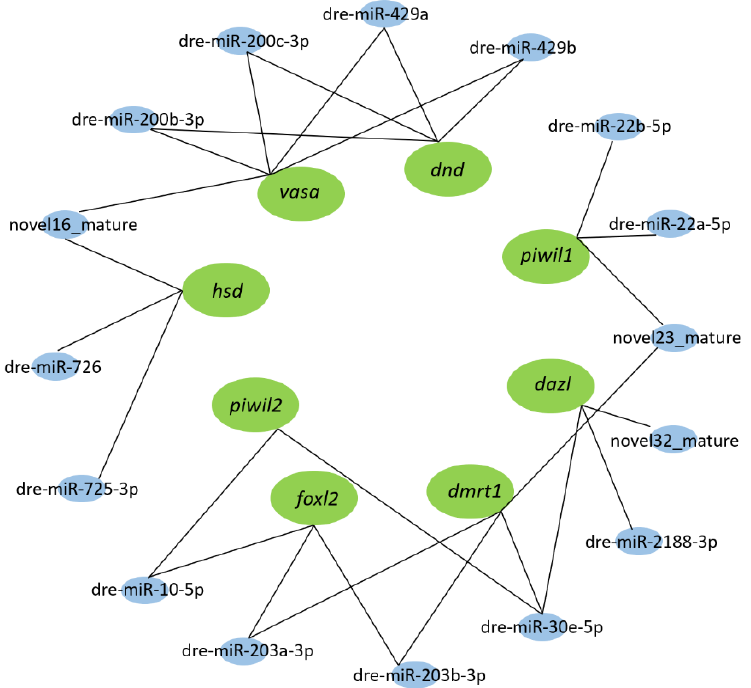
Figure 6. miRNA–mRNA interaction network constructed with sex-related miRNAs and genes using Cytoscape. Green represented target genes, and blue represented miRNAs. One miRNA can interact with many miRNAs. Conversely, one miRNA can bind to multiple genes.